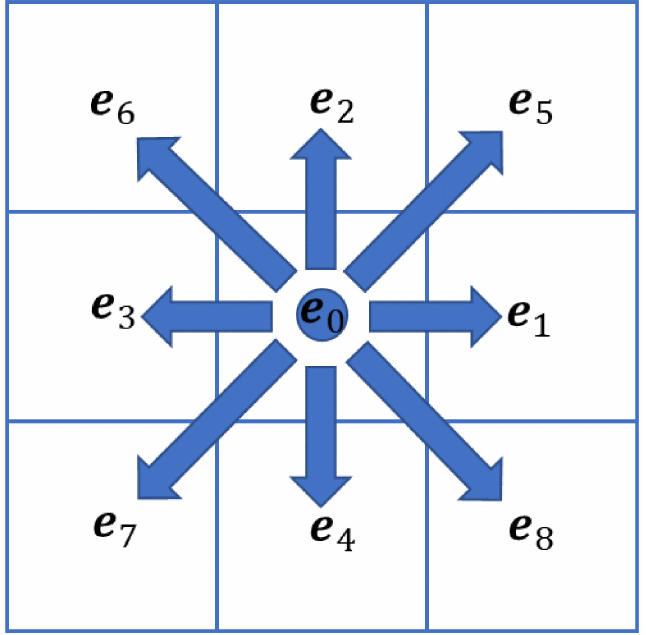
→ → e 1 − e 8 characterize possible particle